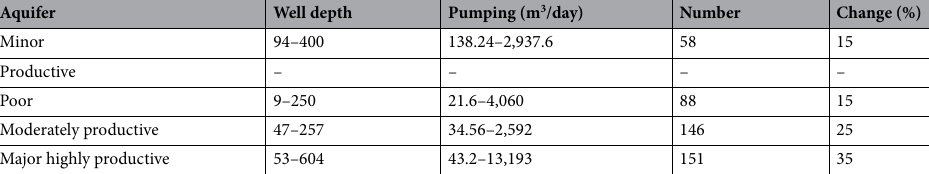
Table 3. Detail of groundwater pumping wells based on hydrogeology map of the study area: Well depth, pumping rate, number of wells located in each hydrogeologic zone, and pumping rate change (%).